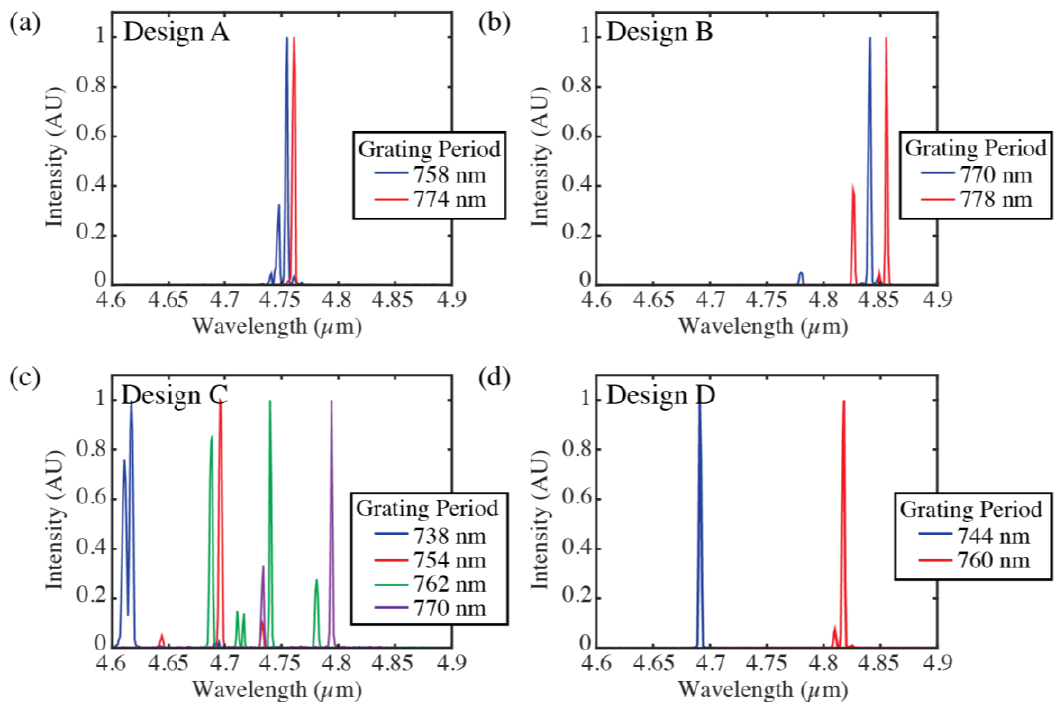
Figure 6. Normalized emission spectra at 20 °C of DFBs with the four designs, as measured with a